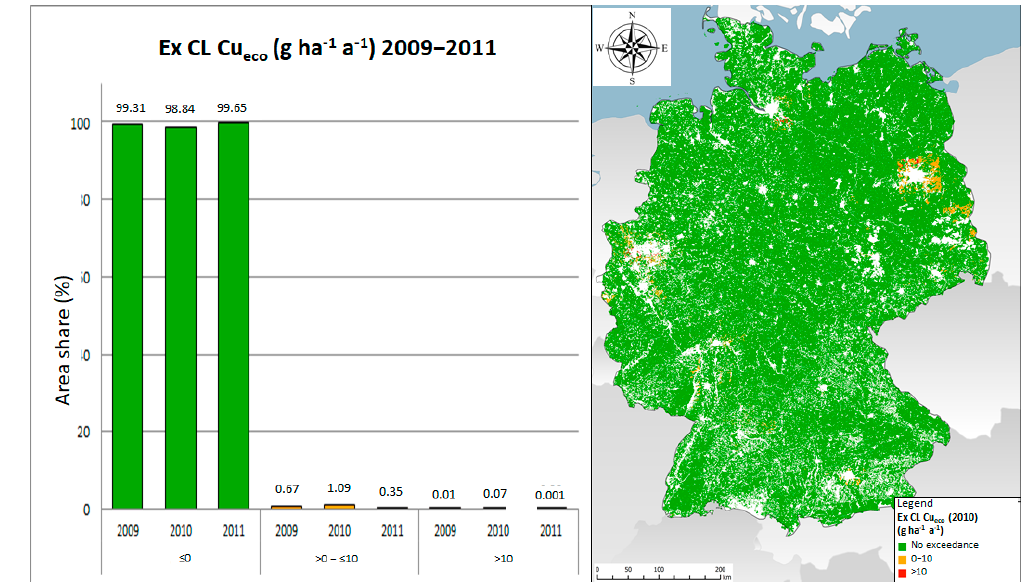
Figure 5. Exceedance of Critical Loads with the protection objective ecosystem integrity by atmospheric Cu deposition.